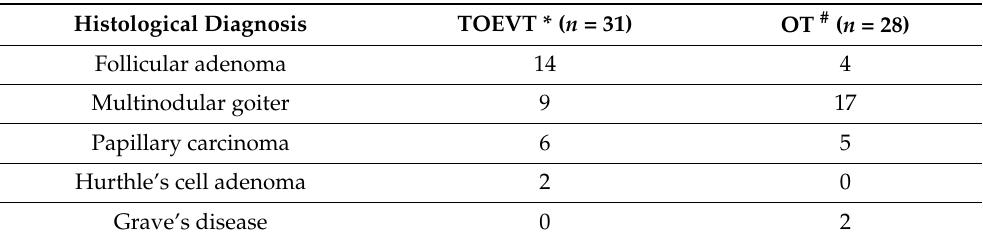
Table 3. Histological diagnoses of the thyroid glands in the transoral endoscopic vestibular and open thyroidectomy procedures ( n =